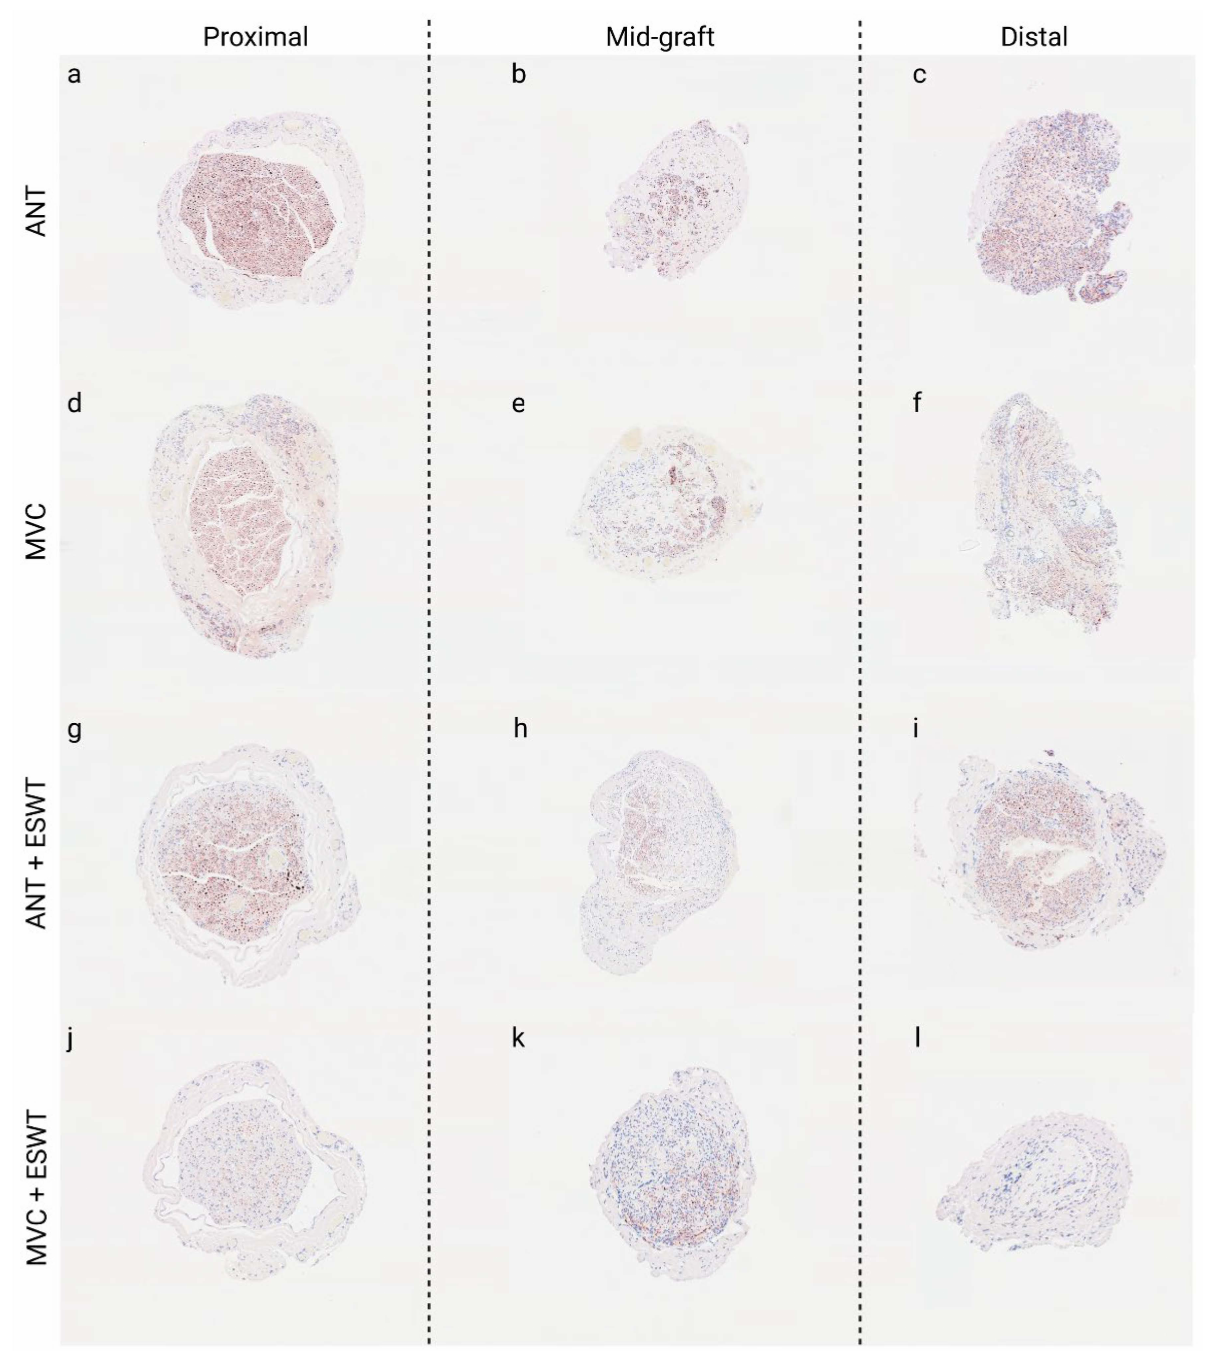
Figure 8. Representative photomicrographs of anti-neurofilament-stained consecutive cross-sections through the regenerated tissue in the proximal nerve segment ( a , d , g , j ), the middle of the nerve graft ( b , e , h , k ) and the distal nerve graft ( c , f , i , l ) at 12 weeks post-surgery. Autologous nerve graft ( a – c ); muscle-in-vein-conduit ( d – f ); autologous nerve graft + extracorporeal shockwave therapy ( g – i ); muscle-in-vein-conduit + extracorporeal shockwave therapy ( j – l ). Scale bar = 200 µ